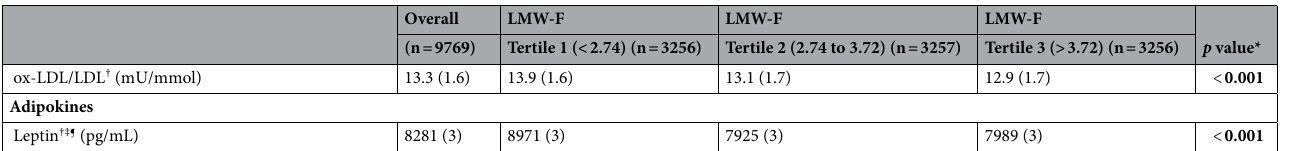
Table 1. Subject demographics and biomarker (traditional and novel) levels at baseline including by LMW-F tertiles. p values < 0.05 are bolded CABG Coronary artery bypass grafting, PTCA Percutaneous transluminal coronary angioplasty. *Variables were compared across the three tertiles using the Mantel–Haenszel ordered test for categorical variables and linear trend for continuous variables. † Log-transformed, geometric means and geometric SD factors presented. ‡ The values below the lower limit of detection were imputed as half the smallest value. ¶ Overall relationship for these variables was quadratic with significant linear and quadratic components.